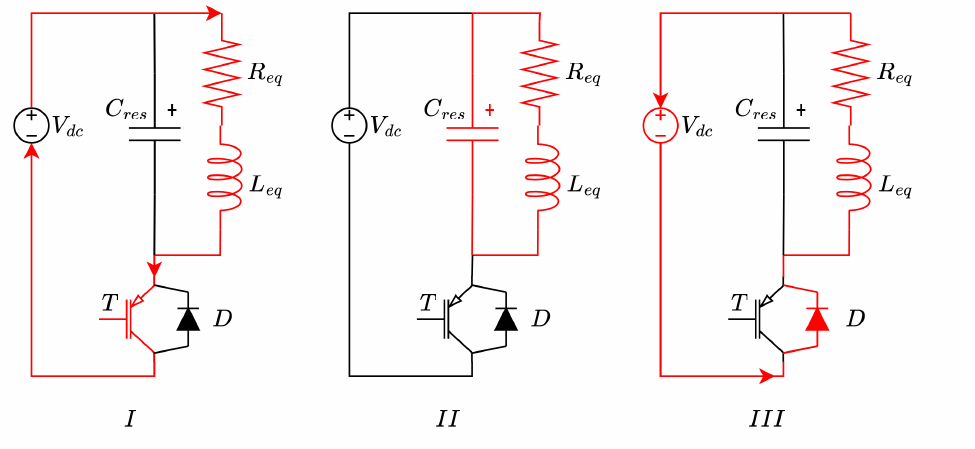
Figure 3. Quasi-resonant converter and three stages of